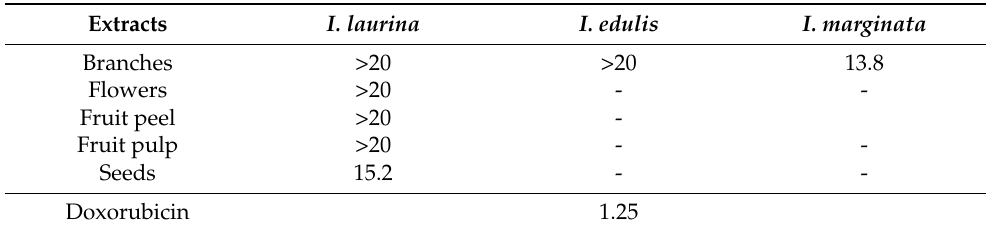
Table 1. Inhibitory concentration (IC 50 ; µ g mL − 1 ) values were obtained from the cytotoxic effect of the ethanolic extracts of the three Inga species against HT-29 cancer cell